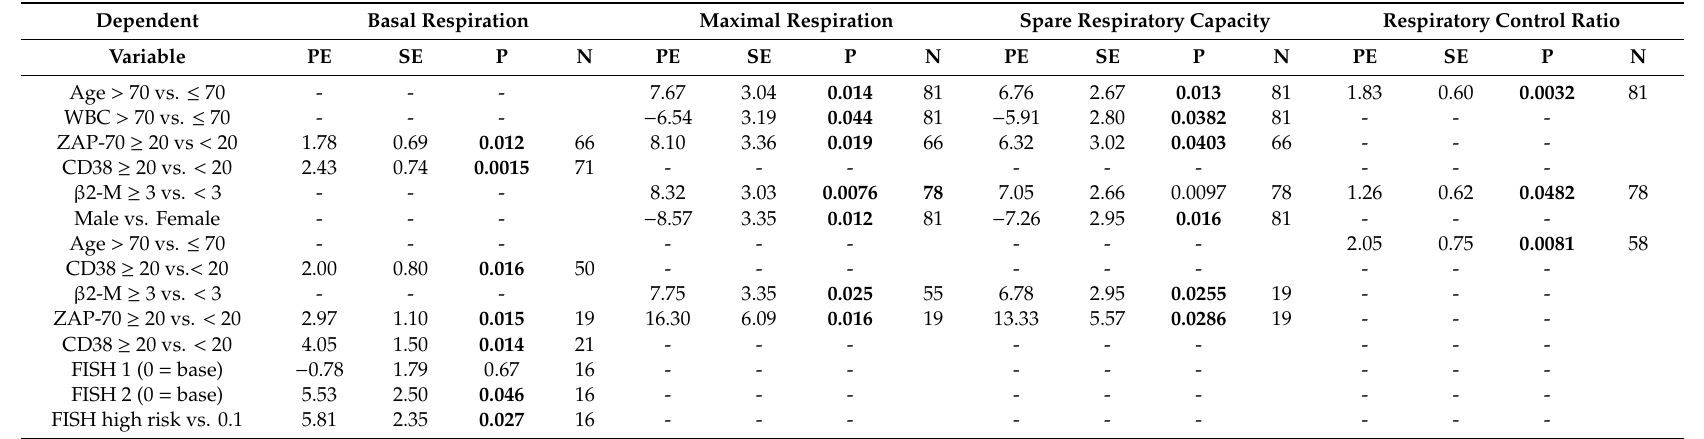
Table 1. Univariable regression analysis of bioenergetics profiles using the dichotomous parameters. Regression analysis of significant parameters identified when evaluating prognostic markers and bioenergetic parameters in the entire cohort or cohort by sex. ZAP-70, zeta-chain-associated protein of 70 kD; CD38, cluster of di ff erentiation 38; WBC, white blood cell count; β 2-M, β 2-microglobulin; PE, parameter estimate; SE, standard error. Bolded values are significant. Dependent Basal Respiration Maximal Respiration Age > 70 vs. ≤ 70 WBC > 70 vs. ≤ 70 CD38 ≥ 20 vs. < 20 Male vs. Female Age > 70 vs. ≤ 70 CD38 ≥ 20 vs. < 20 ZAP-70 ≥ 20 vs. < 20 CD38 ≥ 20 vs. <